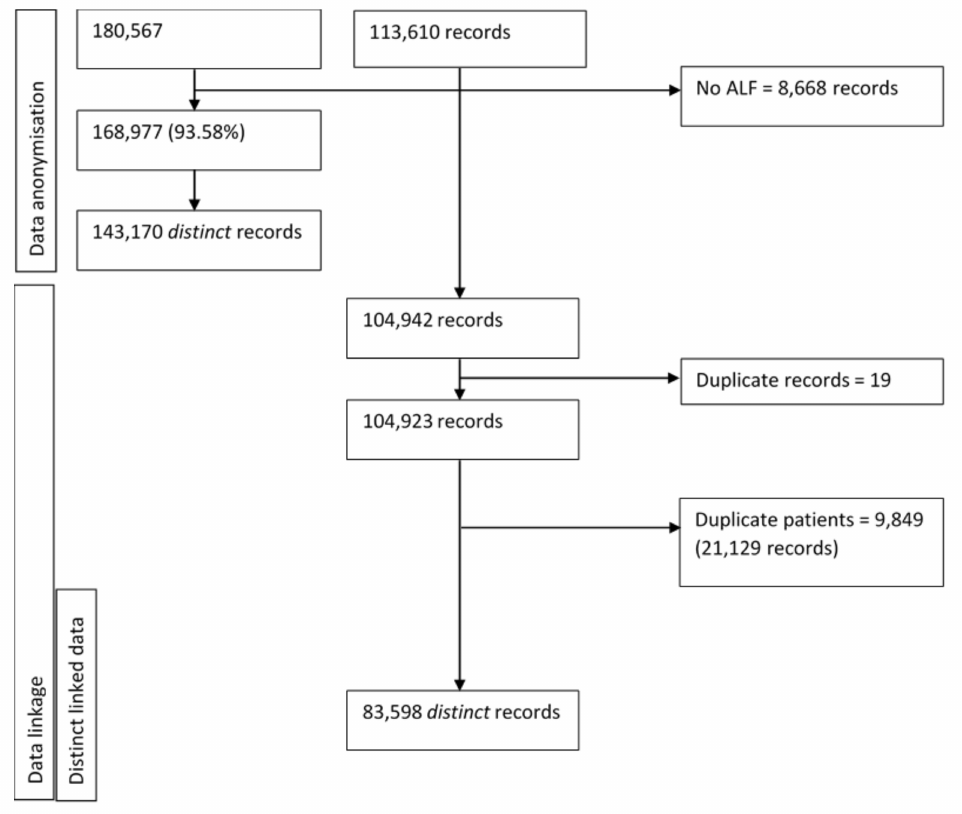
Figure 1. Overview of data linkage